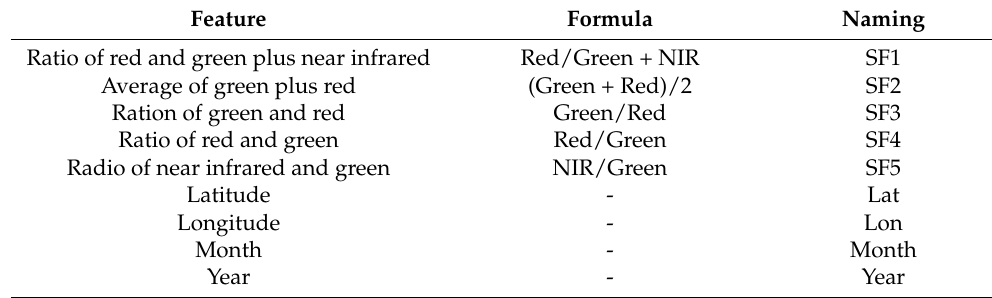
Table 6. List of additional features derived from the HLS dataset and lake inherent characteristics.